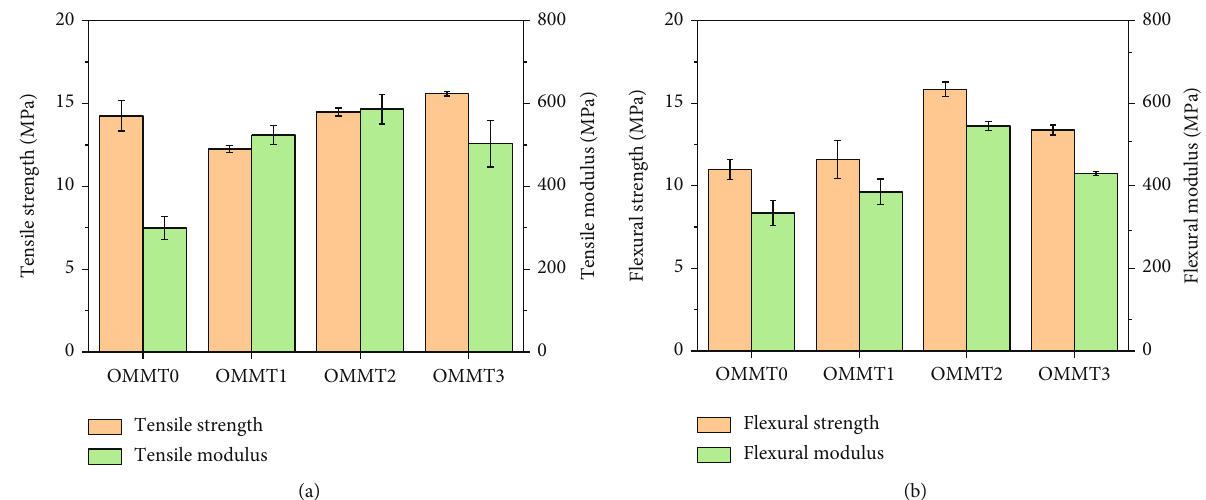
Figure 6: (a) The tensile strength and tensile modulus and (b) the fl exural strength and fl exural modulus of SUPAs with di ff erent OMMT contents.